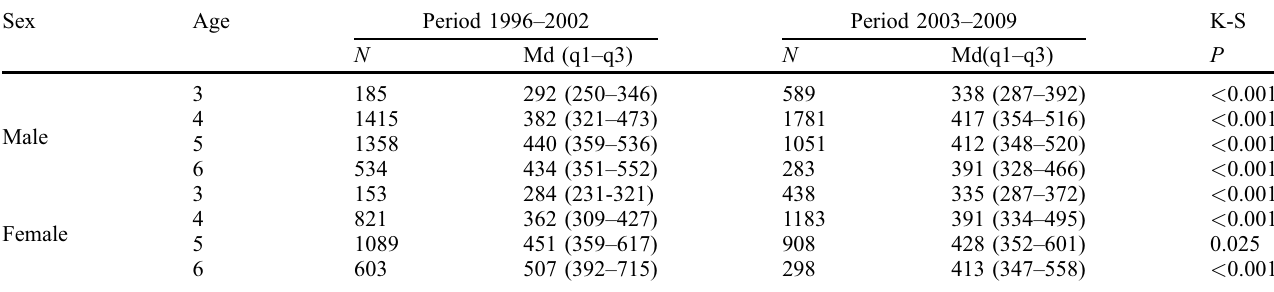
Table A.5. Age-speci fi c median (Md) weight (g) of anadromous male and female white fi sh in two class periods (1996 – 2002; 2003 – 2009) in the Gulf of